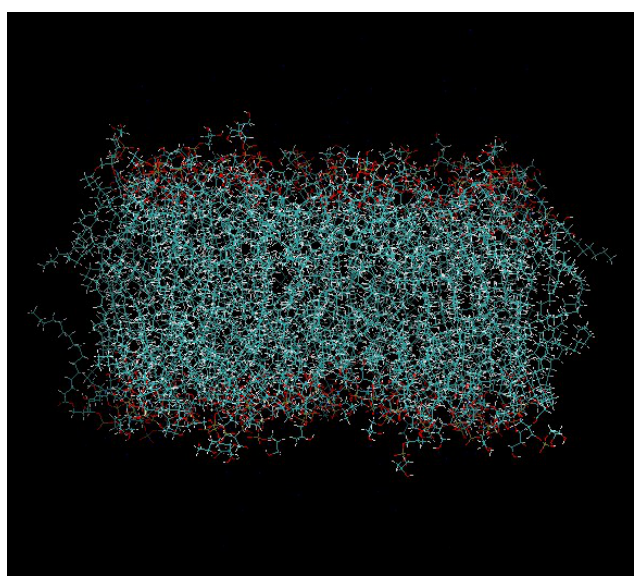
Fluids 2019 , 4 FOR PEER REVIEW Figure 2 . The pre-equilibrated model of the DPPG membrane that was used in our study. Figure 2. The pre-equilibrated model of the DPPG membrane that was used in our study. Table 1 . Number of molecules/ions of each type included in the simulated system.